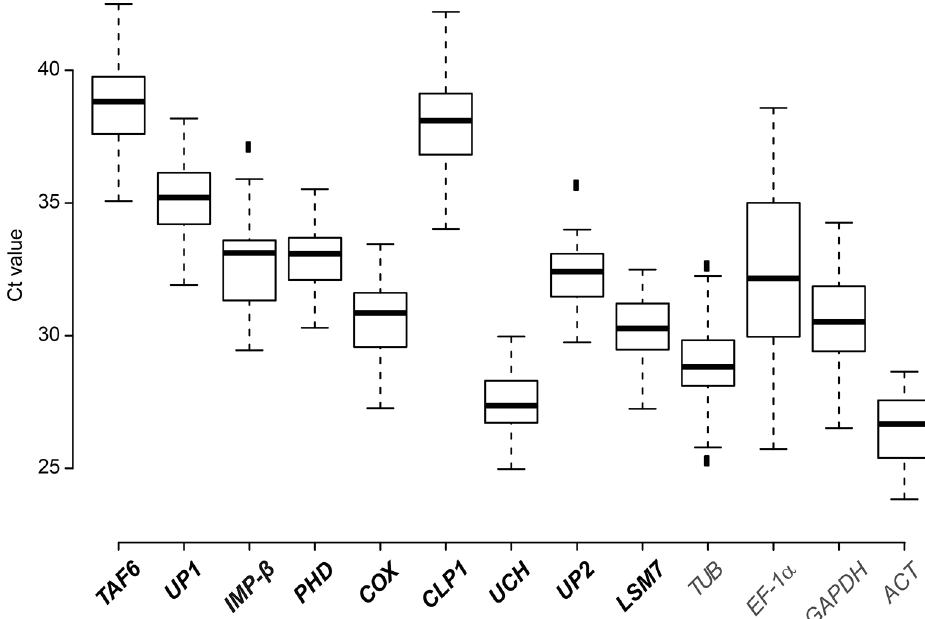
Fig 6. Expression profiles of new candidate reference genes and classical housekeeping genes from pepper. Box plot graphs of Ct values for each reference gene tested in all samples (n = 48). Ct values are inversely proportional to the amount of template. The boxes indicate the 25/75 percentiles, median values are represented by black lines. Whisker caps indicate the value range, dots represent outliers. New reference gene candidates are indicated in